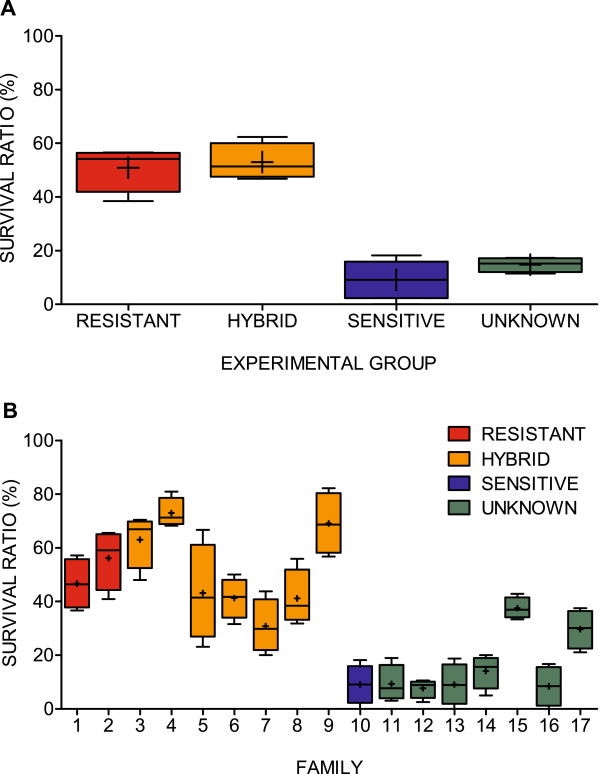
Variability in survival ratios in the EB trial. EB challenge results presented as ratios (%) between number of surviving individuals and the total numbers of trial lice separated by the four experimental groups (A), and the 17 families (B). Data presented from the four replicate tanks, where coloured boxes represents the 25-75% quartile, whiskers at min - max, line at median and (+) at mean values.